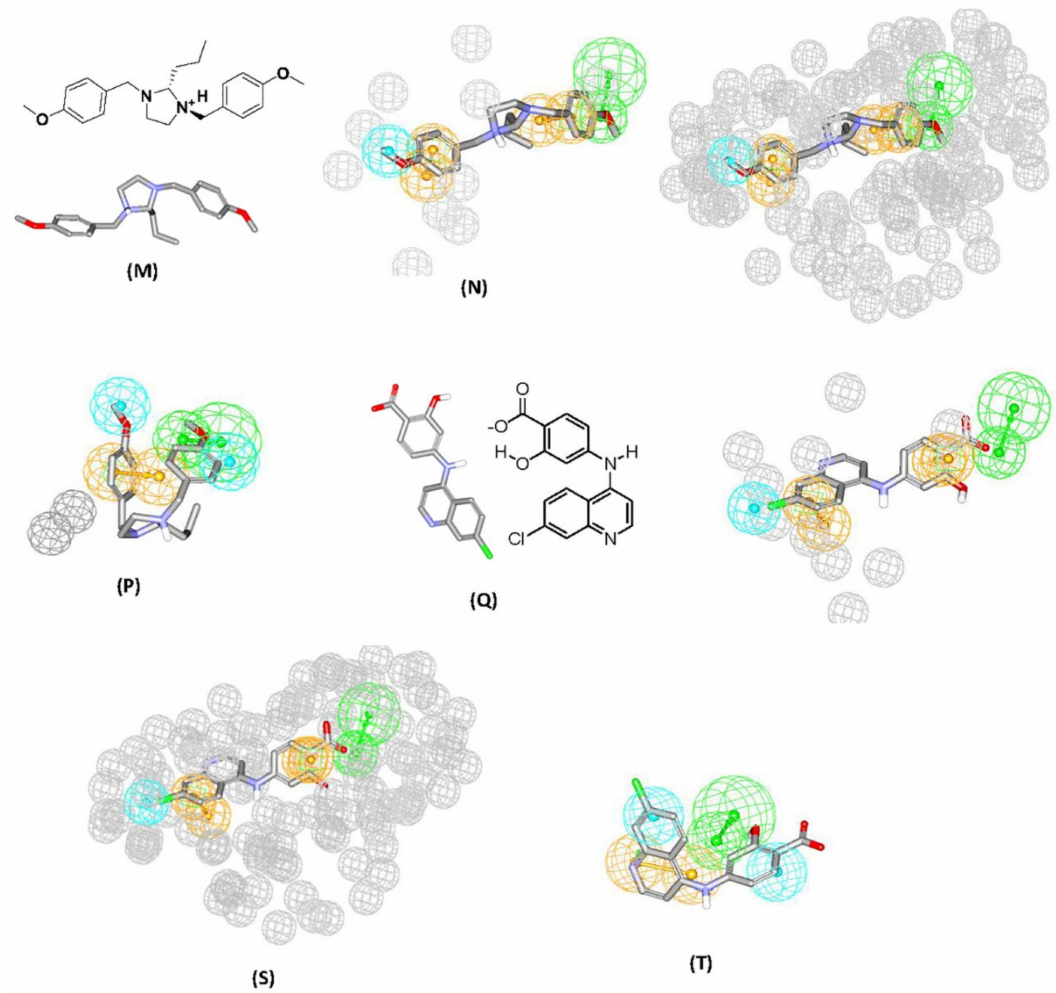
Figure 6. ( A ) Chemical structure of hit 85 (NCI 14040), (B) Hit 85 (NCI 14040) fitted to Hypo(SB-1) pharmacophore before refinement. ( C ) Hit 85 (NCI 14040) fitted to sterically Refined-Hypo(SB-1) pharmacophore. ( D ) Hit 85 (NCI 14040) fitted to the Hypo(SB-2) pharmacophore, ( E ) Chemical structure of 88 (NCI 1576) , (F) Hit 88 (NCI 1576) fitted to Hypo(SB-1) pharmacophore before refinement, ( G ) Hit 88(NCI 1576) fitted to sterically Refined-Hypo(SB-1) pharmacophore. ( H ) Hit 88(NCI